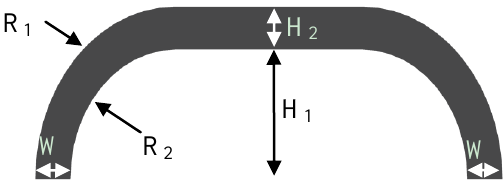
Figure 2. Cross section of the Skilsens pad. Highlighted are the internal (R (R ) radii, the upper thickness (H 1